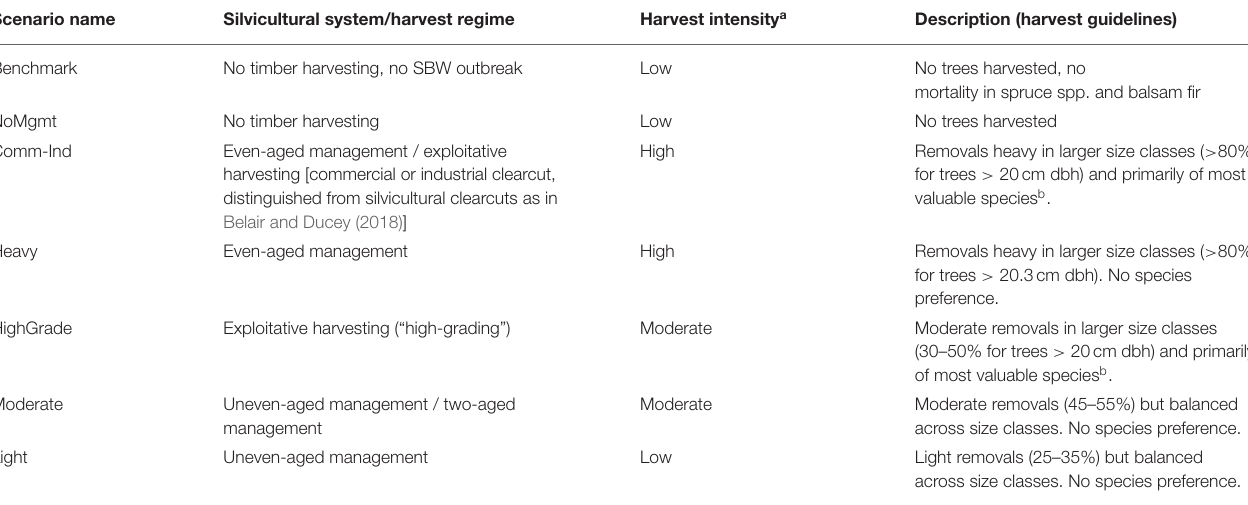
TABLE 3 | Management scenario descriptions and Forest Vegetation Simulator (FVS) model harvest guidelines.